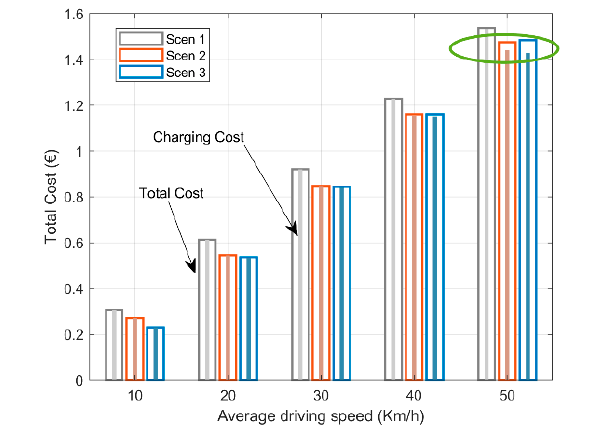
Figure 5. The total cost (and separately the cost for charging) that a plug-in hybrid electric vehicle (PHEV) user will have to pay for commuting over 24